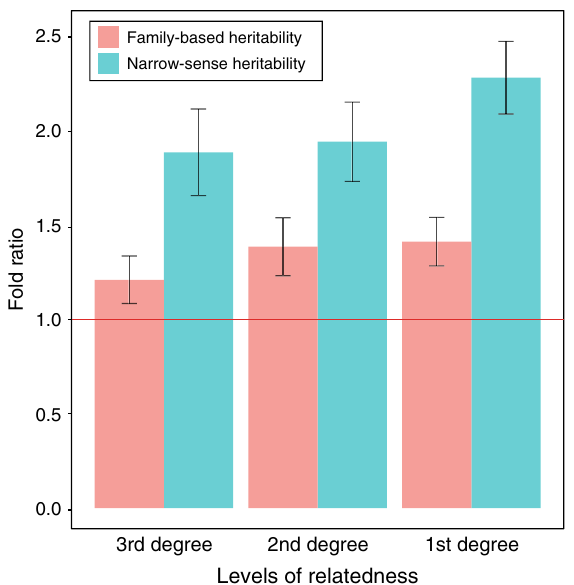
Fig. 3 The ratio between the empirical and theoretical prediction accuracies in the small-scale design. The theoretical prediction accuracy was calculated with family-based heritability or narrow-sense heritability. Narrow-sense heritability is pre-computed by Neale lab 33 from the original UKB data with unrelated individuals. Family-based heritability of each trait is estimated for each trait by GREML using small-scale design 10 . Theoretical prediction accuracy is formulated as a function of the effective number of chromosome segments, heritability and the number of phenotypic observations for each trait. The effective number of chromosome segments is estimated as the inverse of the variance of relationships between reference and target sample. The main bars represent the mean values averaged over the analyses of 50 traits. The error bars show the 95% con fi dence intervals of the mean values. The red horizontal line indicates a ratio of 1.